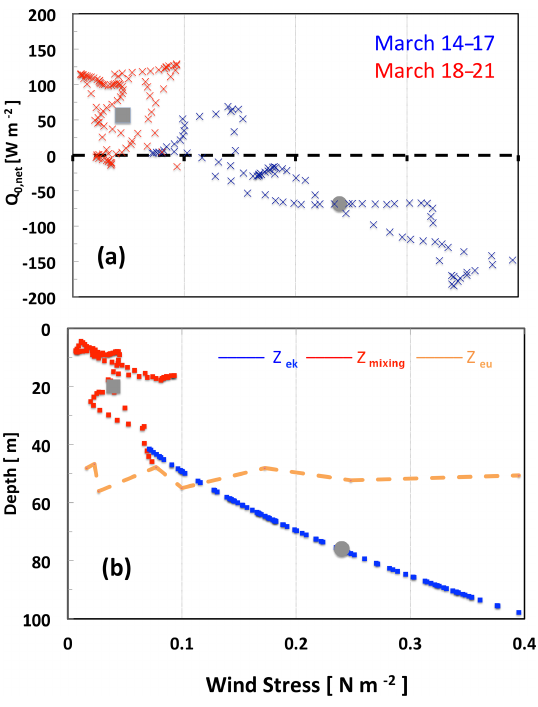
Figure 4. Changes in physical parameters (hourly values) at the onset of the 2016 bloom during two consecutive periods of 4d, 14–17 March (blue) and 18–21 March (red), as a function of wind stress (a) ; net surface heat flux (b) ; and depths of the Ekman, mixing and euphotic layer. Grey circles and grey squares indicate mean val- ues, respectively, on 17 and 18 March. For comparison, the orange line shows the euphotic layer depth (14–21 March).